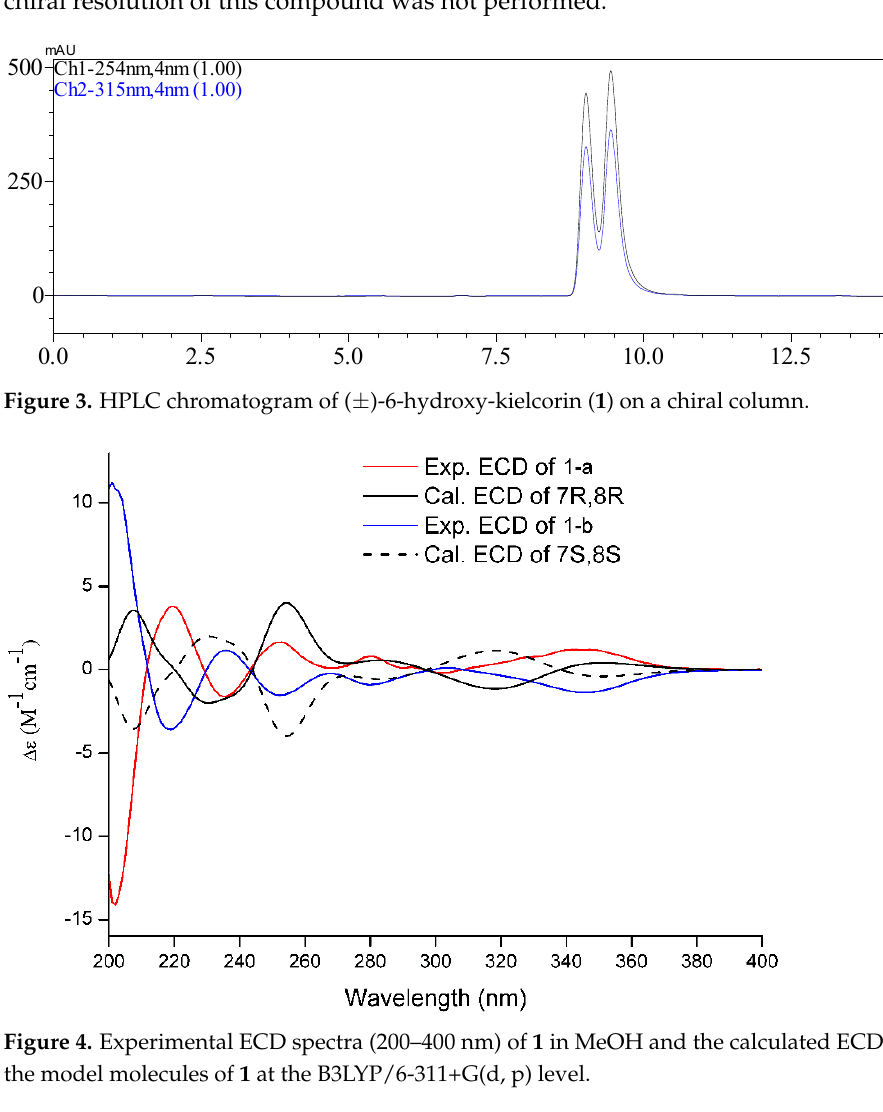
Figure 2. Selected HMBC (arrow) correlations of compounds 1, 2 and 7 .